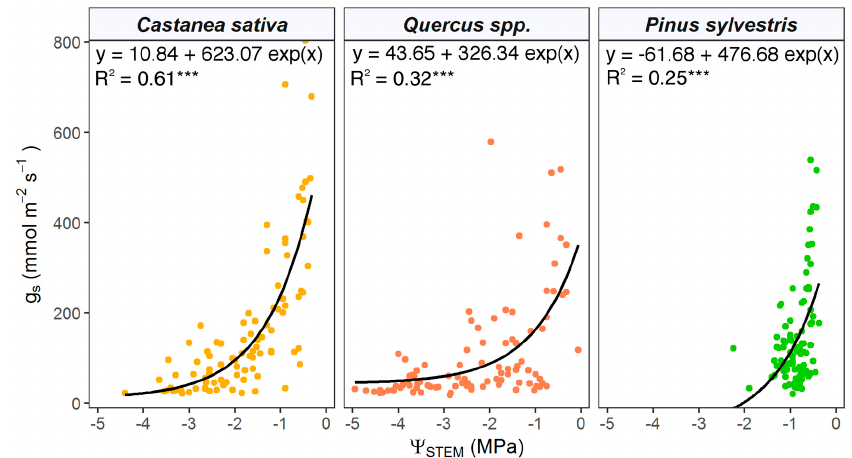
Figure 4. Variation of mean estimated stomatal conductance (g s ) and their standard errors induced by species treatment and year. Estimates within and across panels that do not share the same letter are significantly different at p < 0.05.